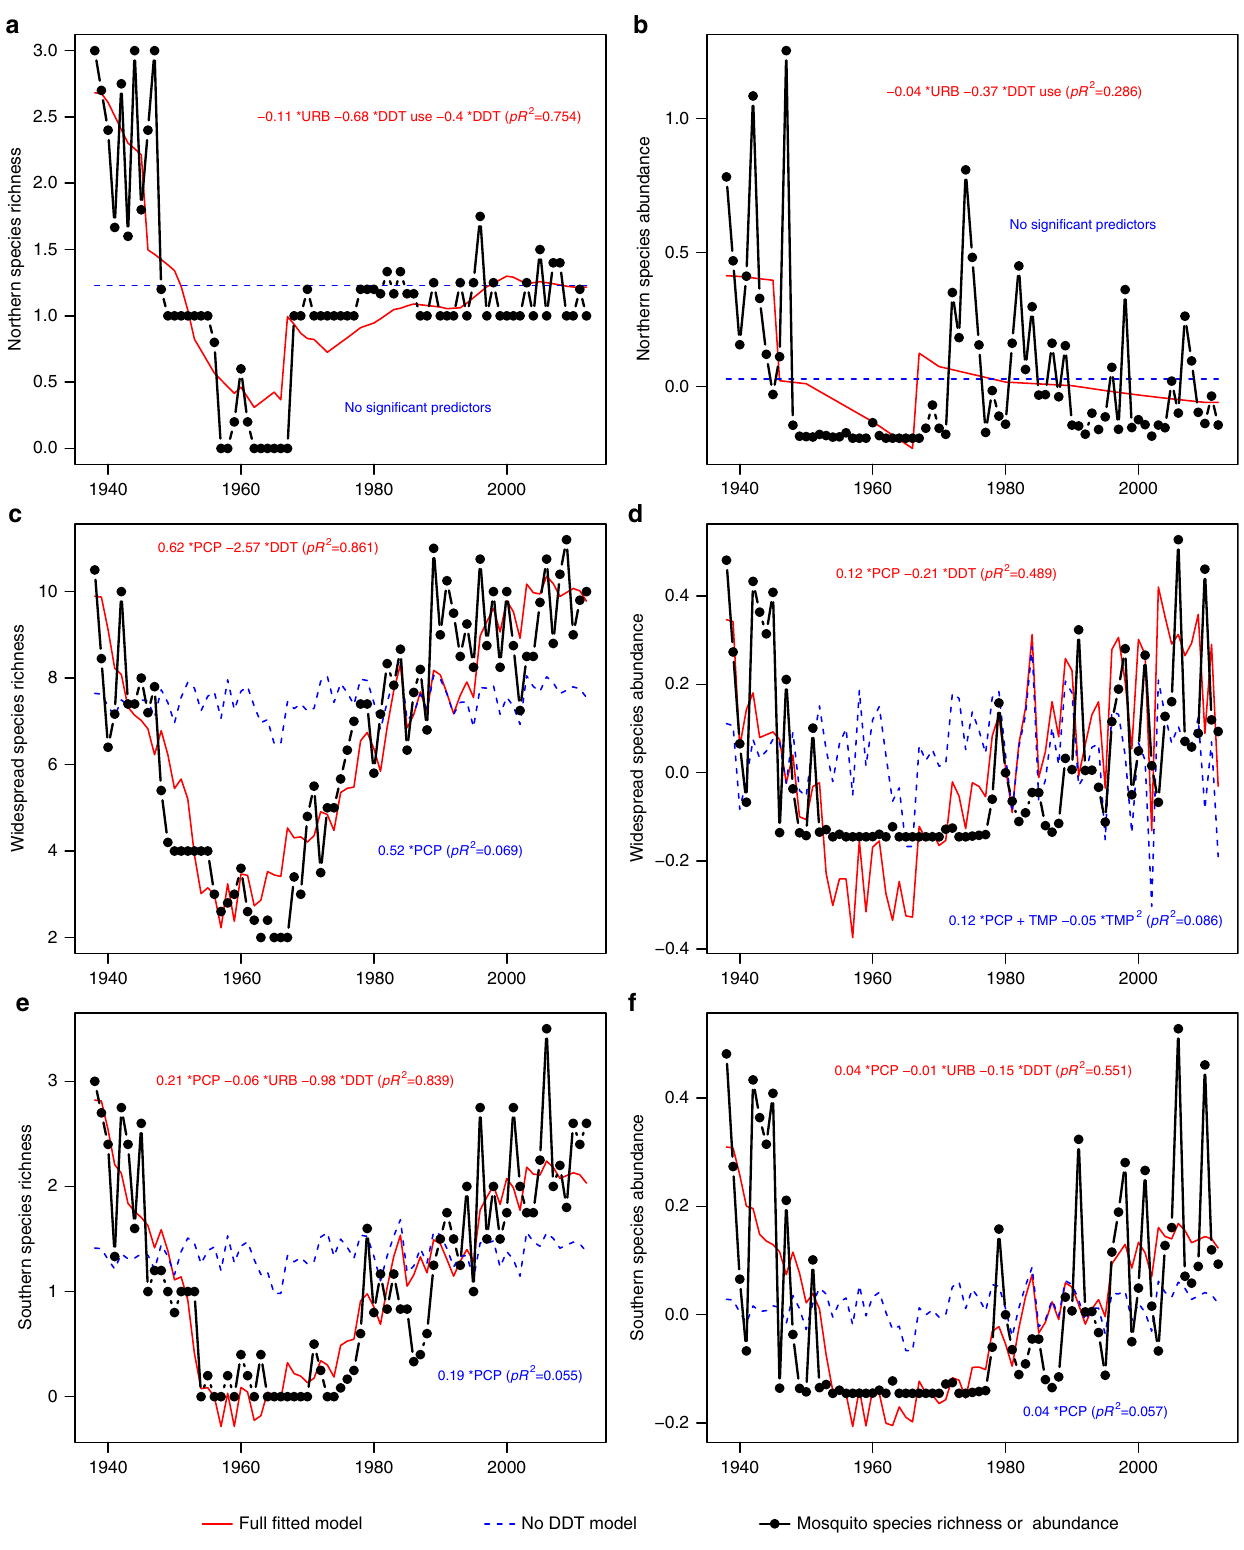
Figure 6 | Regional fitted models and data for mosquito species richness and abundance in New York. Black line and dots show mosquito species richness for Northern ( a ), Widespread ( c ) and Southern ( e ) groups of mosquitoes or relative abundance ( b , d , f ). Red lines show full models, and blue dashed lines shows reduced models excluding DDTparameters. The equation in each panel gives the fitted model with all significant predictors ( P o 0.05) and fraction of variance explained (pseudo- R 2 , ‘ pR 2 ’) from the generalized least squares models (red font-full model, blue font- reduced model with DDT parameters excluded). The abbreviations designate DDTconcentration (DDT, Z -scores), DDTuse by the mosquito control districts (yes/no), precipitation (PCP, standardized precipitation index), urbanization (URB, human population in 100,000), average annual temperature November through October (TMP, (cid:2) C). For relative variable significance in the model see Table